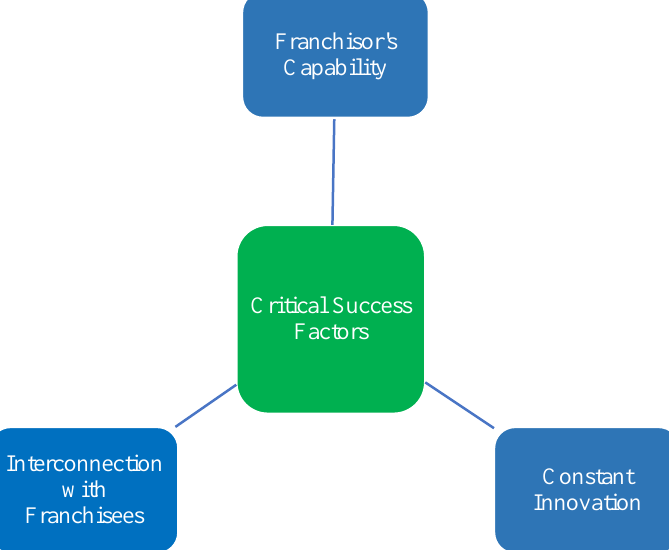
Figure 1. Framework for the critical success factors of franchising business.